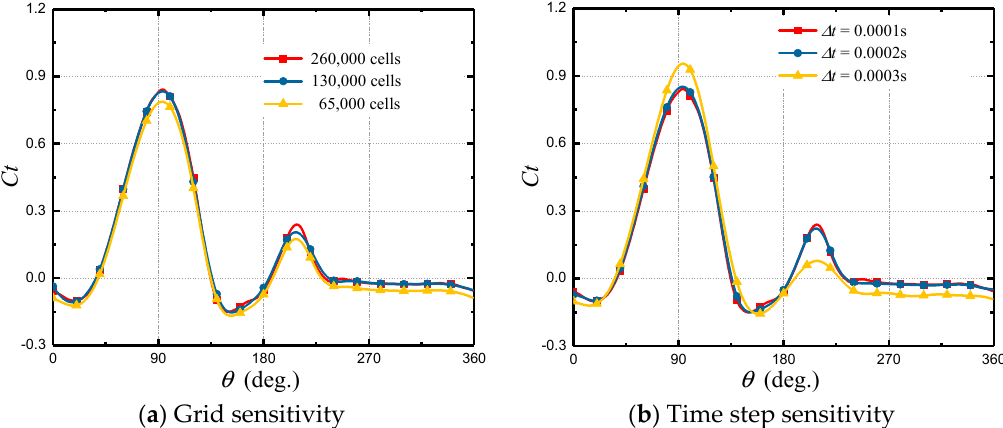
Figure 8. CFD validation: the tangential force coefficient with azimuth.